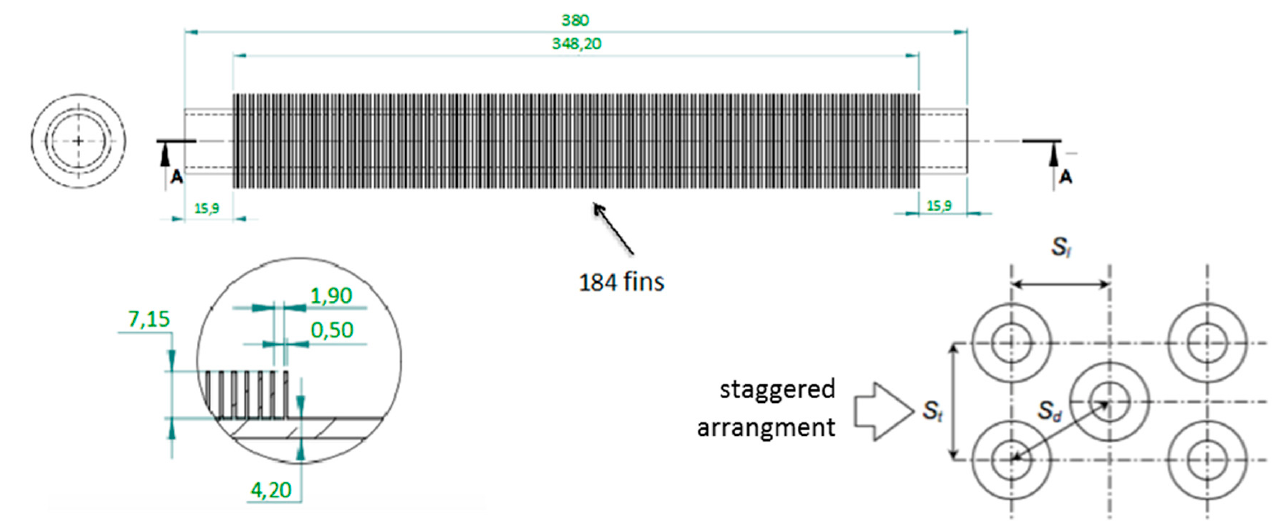
Figure 5. Drawings and details of the inner parts of the MSH heat exchanger mock up.